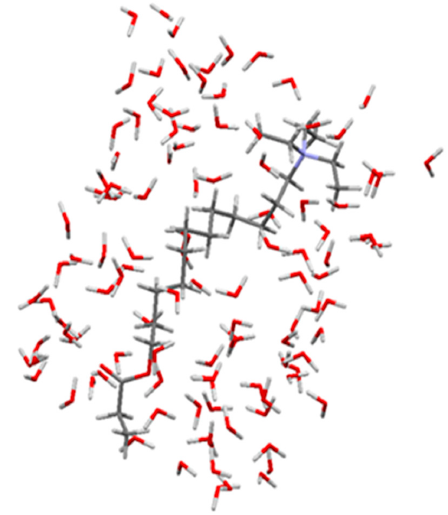
Figure 3. Model used for the quantum/molecular mechanics (QM/MM) calculations. Red = oxygen; white = hydrogen; grey = carbon; and blue = nitrogen.